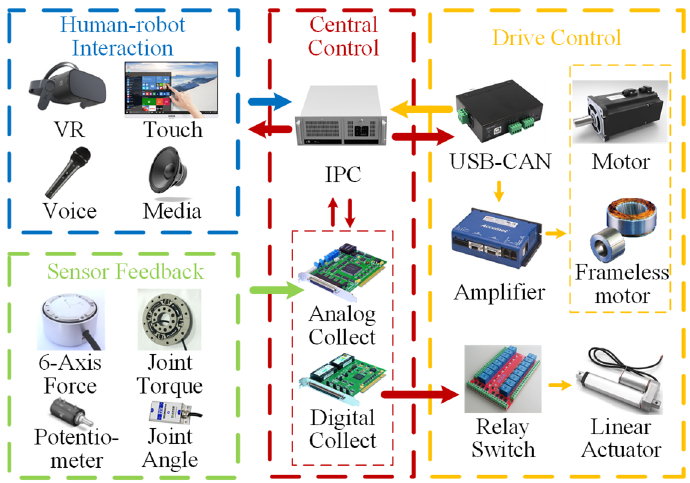
Figure 3. Electric control system. The arrow represents the direction of information transmission.